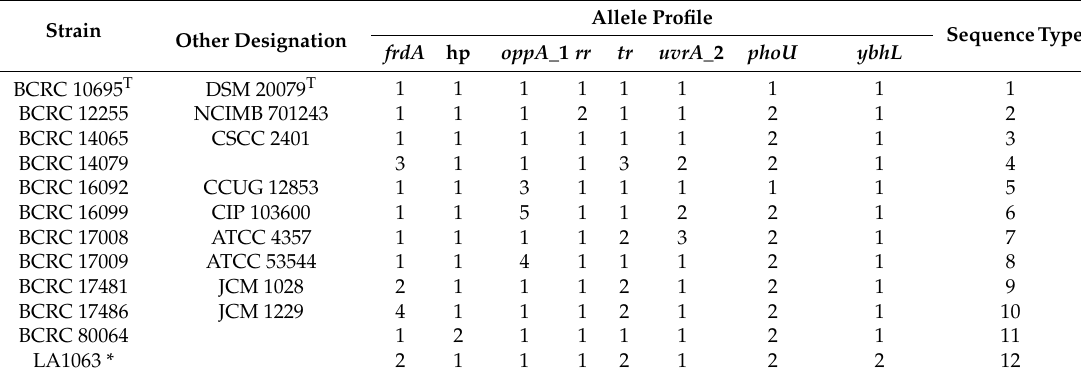
Table 4. Strain typing of 11 reference Lactobacillus acidophilus strains and 1 commercial probiotic strain by multilocus sequence-typing